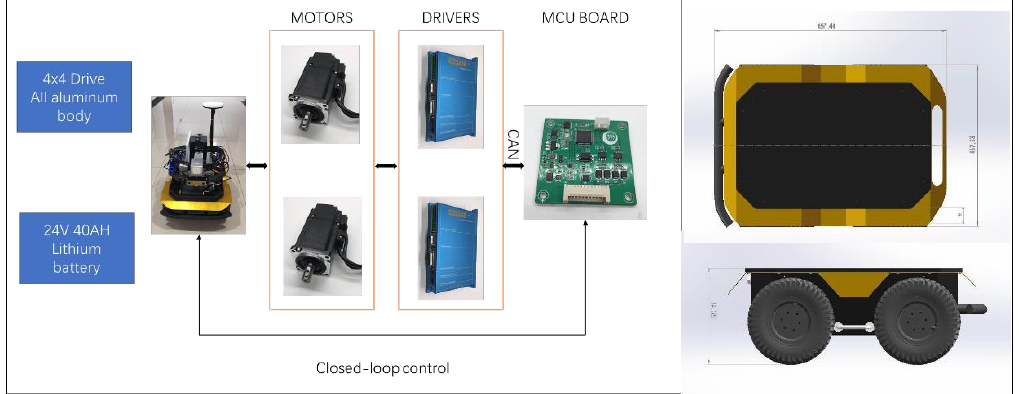
Figure 3. Mechanical layout and onboard control diagram.